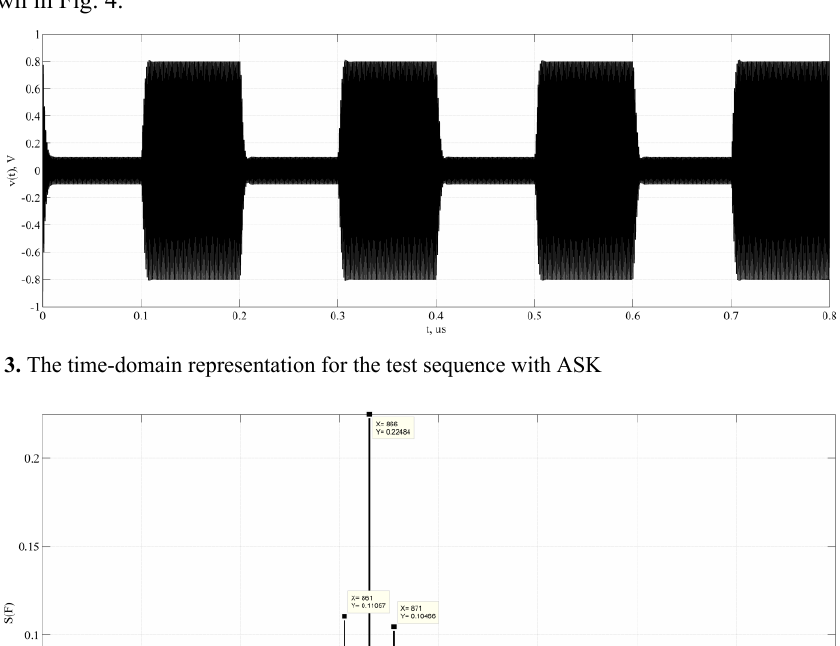
the input capacitance C to 70% from the initial value of Monza 4QT chip for 866 IN